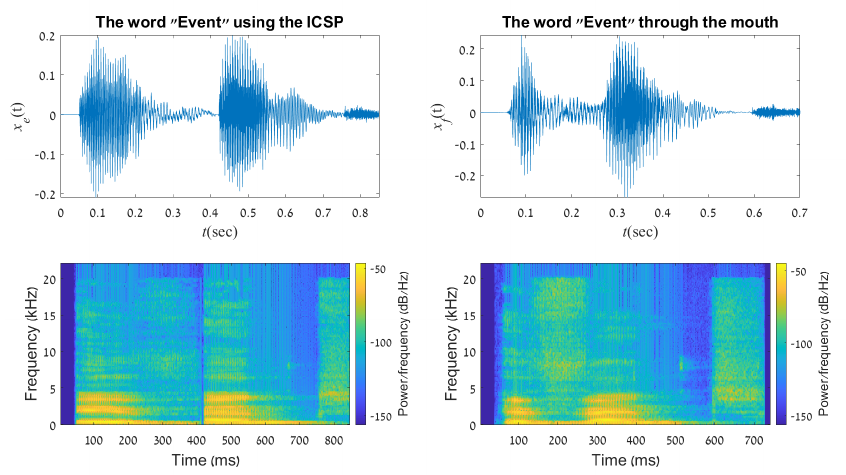
Figure 9. A representation of the word ”Event” in time domain and frequency spectrogram, created using the ICSP ( left column ) and the human mouth ( right column ).